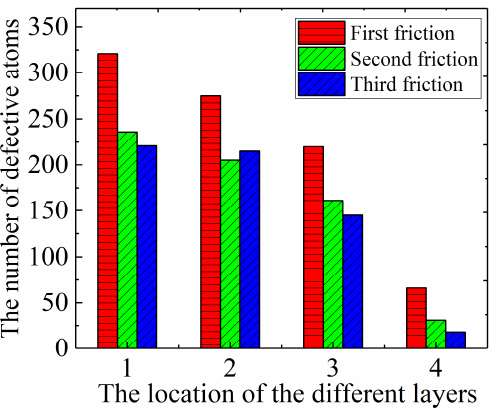
Figure 12. The number of defect atoms in different layers after three times of friction.